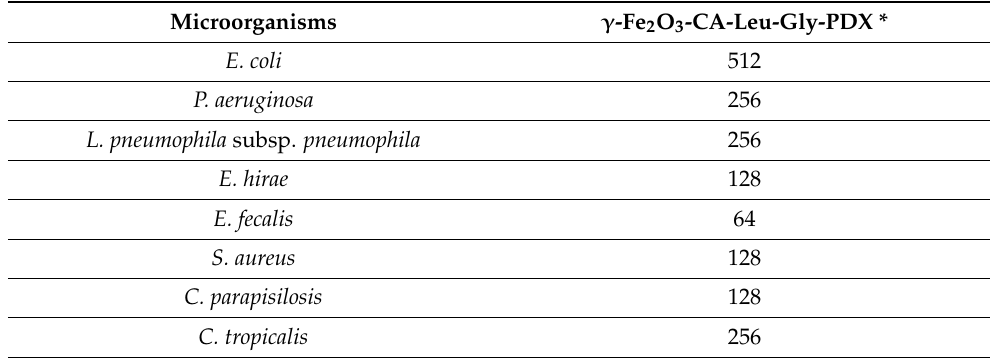
Table 1. The minimum inhibition concentration (MIC) of test